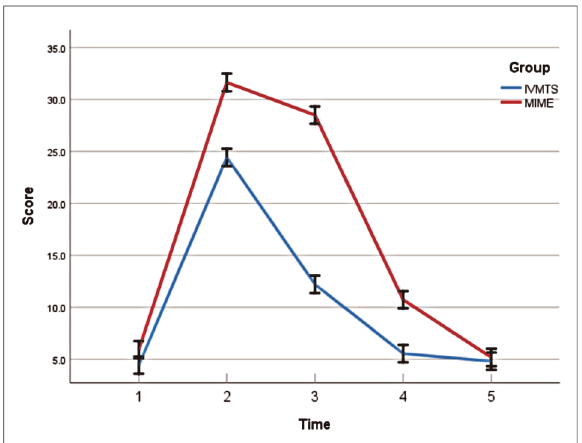
FIGURE 2 Comparison of QLQ-OES18 scores (pain) between the two groups before and after operation. IVMTE, in fl atable videoasisted mediastinoscopic transhiatal esophagectomy; MIME, minimally invasive Mckeown esophagectomy; Time 1, 1 day before operation; Time 2, 1 weeks after operation; Time 3, 2